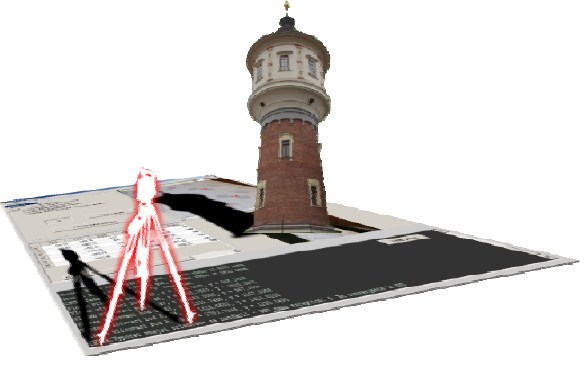
Figure 12. Complex view on water tower